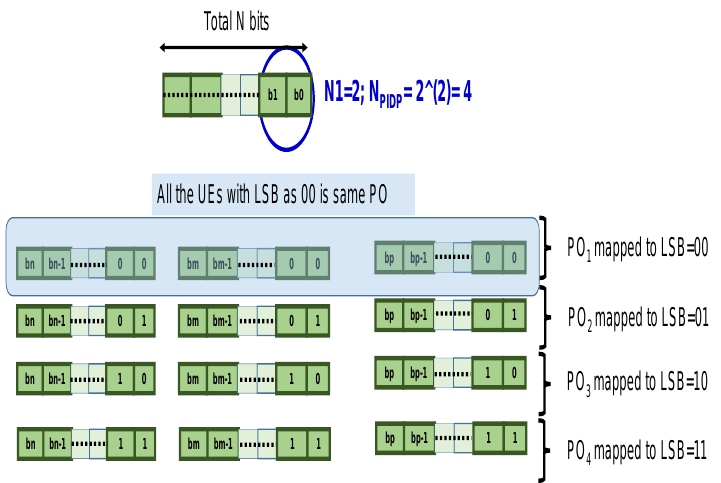
Figure 4. Configuration of paging occasions (POs) and the distribution of UE over POs in PIDP for N 1 =